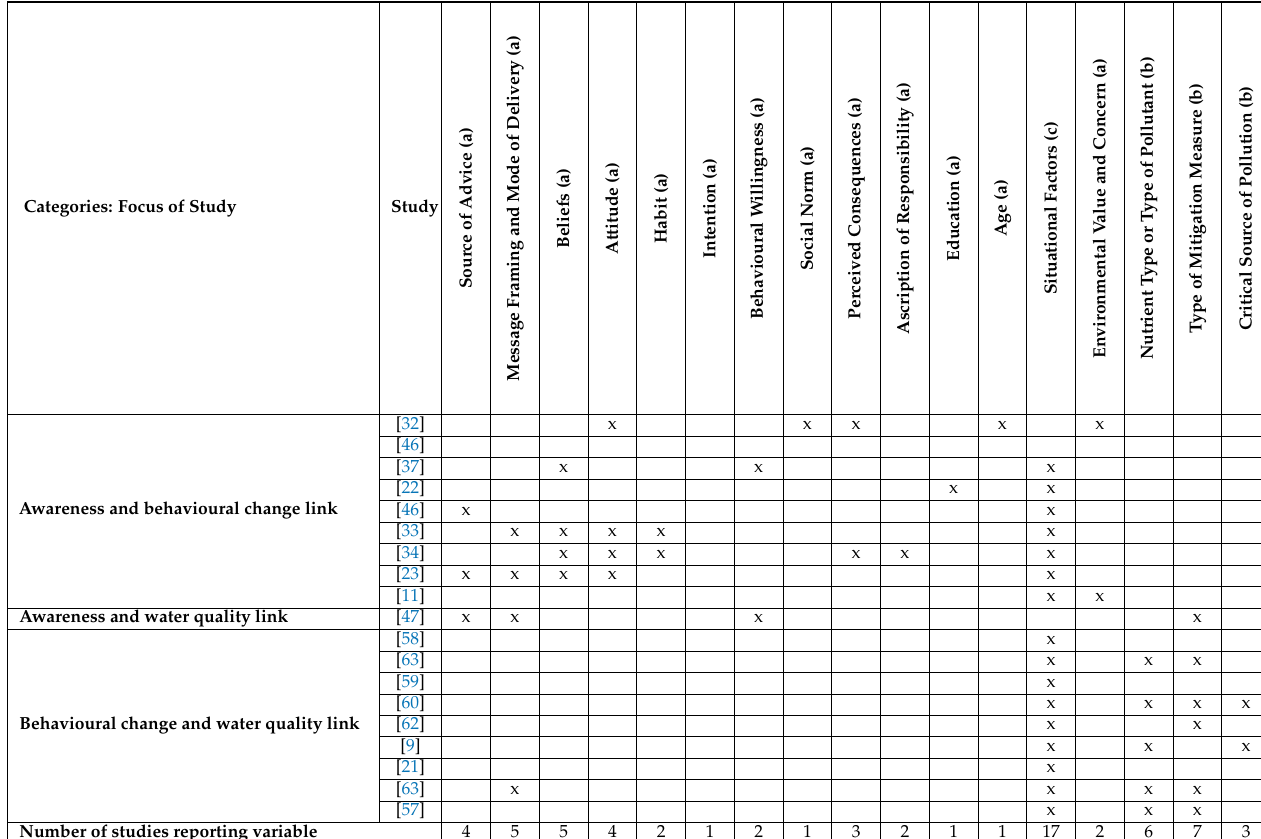
Table A2. Summary of variables affecting the awareness–behavioural change–water quality